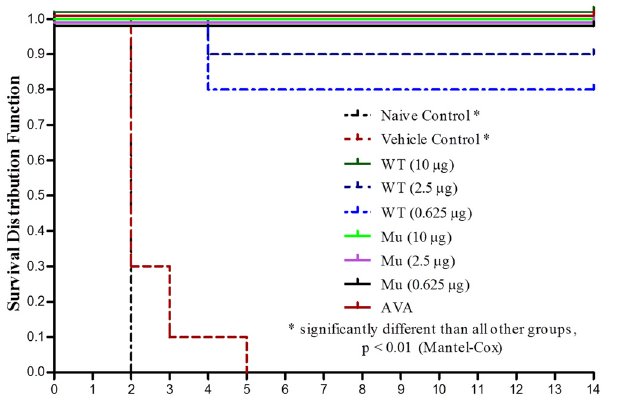
Fig 3. Kaplan-Meier Survival Curve of vaccinated, unvaccinated control, and sham vaccinated control rabbits.